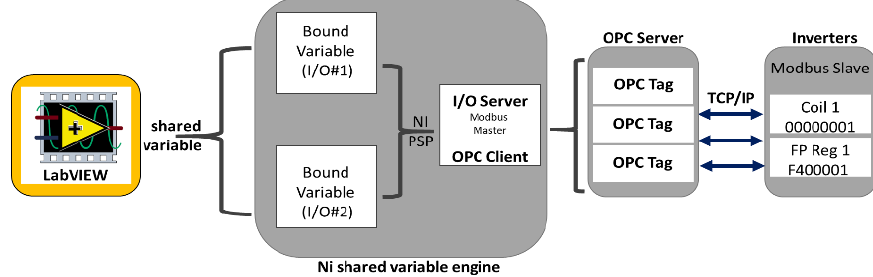
Figure 15. NI shared variable engine for connectivity between LabVIEW and OPC.